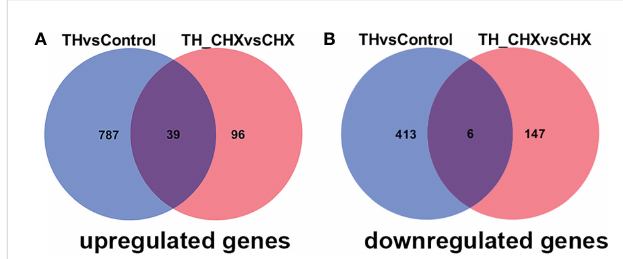
FIGURE 5 Venn diagrams illustrating the overlap in DETs between TH vs. control and TH_CHX vs. CHX. The numbers in each circle (blue circle, TH vs. control; red circle, TH_CHX vs. CHX) indicate the total number of different genes in each comparison group, and the number in the overlapping areas is the number of shared genes between two comparison groups. (A) A total of 826 genes were upregulated by TH alone (TH group compared with control group), whereas 135 were upregulated by TH in the presence of CHX (TH_CHX group compared with CHX group). Among them, 39 genes were commonly upregulated by TH or TH_CHX. (B) A total of 419 genes were downregulated by TH alone (TH group compared with control group), whereas 153 were downregulated by TH in the presence of CHX (TH_CHX group compared with CHX group). Among them, six genes were commonly downregulated by TH or TH_CHX. DETs, differentially expressed transcripts; TH, thyroid hormone; CHX,